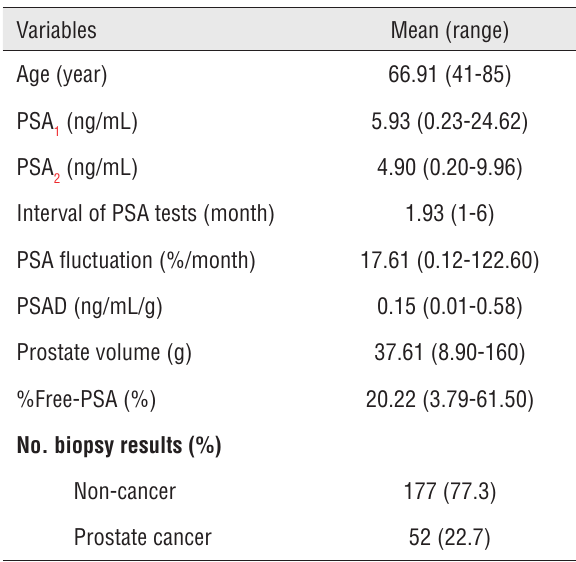
Table 1 - Baseline characteristics of